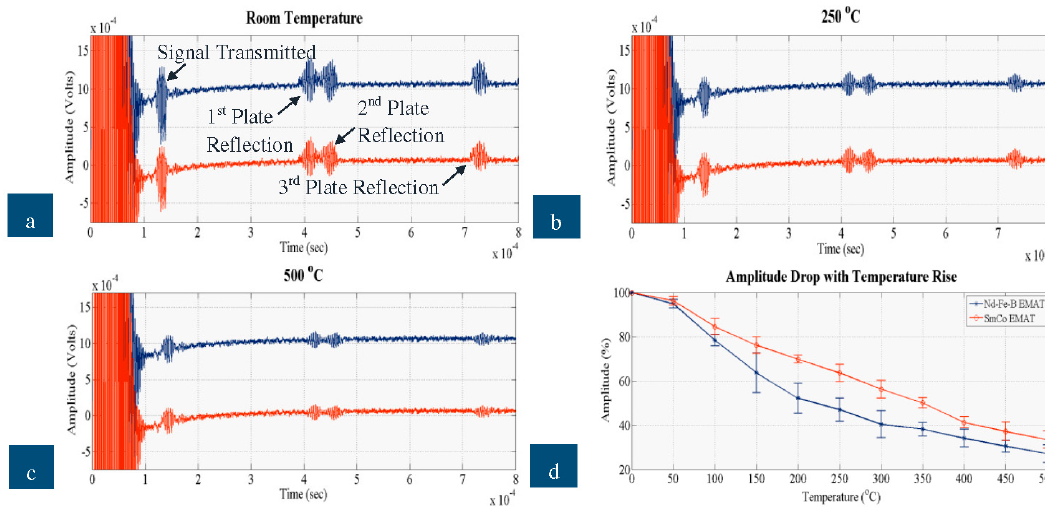
Figure 11. Signal received by Nd-F-B and SmCo EMAT on stainless steel at ( a ) room temperature; ( b ) 250 °C; ( c ) 500 °C; ( d ) amplitude drop against temperature rise.